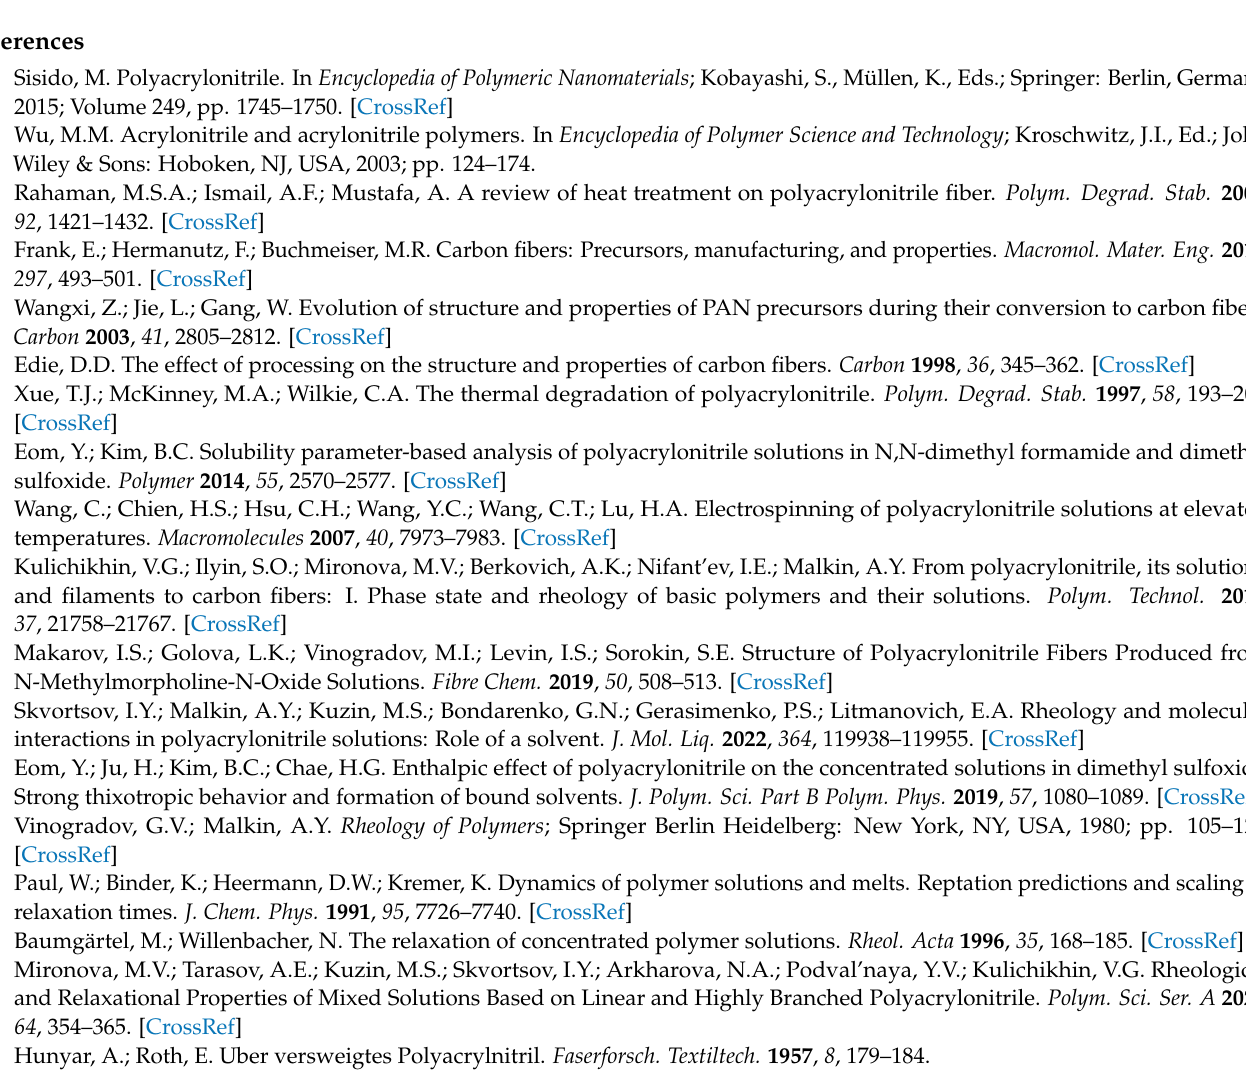
Figure A2. Frequency dependences for concentrated solutions of PAN copolymers ranks of AlkA1 and AlkA2 at 25 °C, where: ( a )—methyl acrylate; ( b )—butyl acrylate; ( c )—2-ethylhexyl acrylate, ( d )—lauryl acrylate.